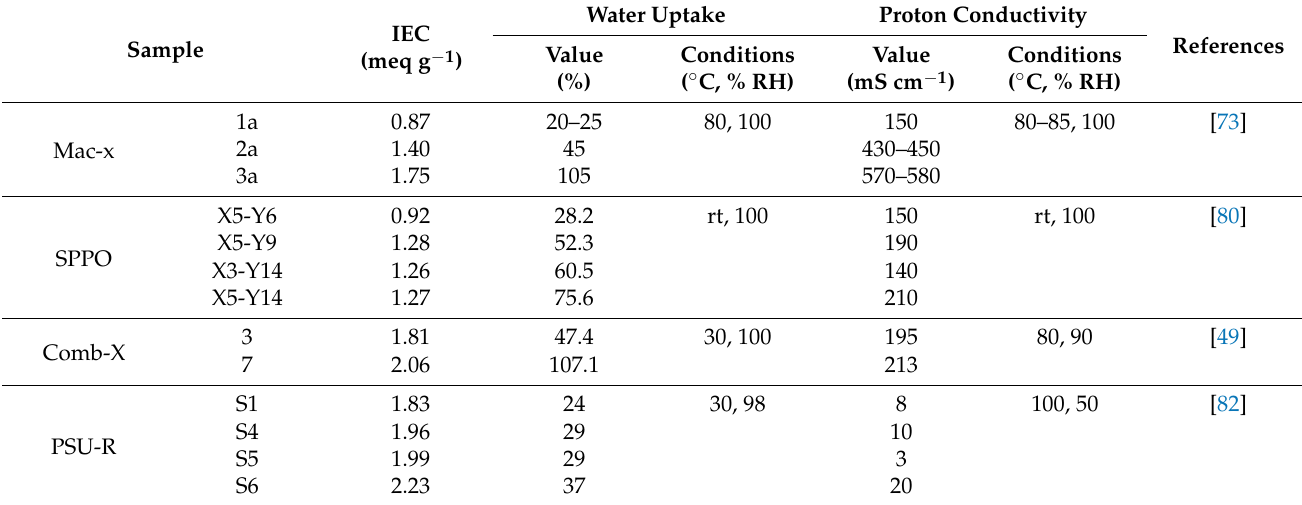
Table 4. Properties of graft/comb-shaped copolymer-based polymer electrolyte